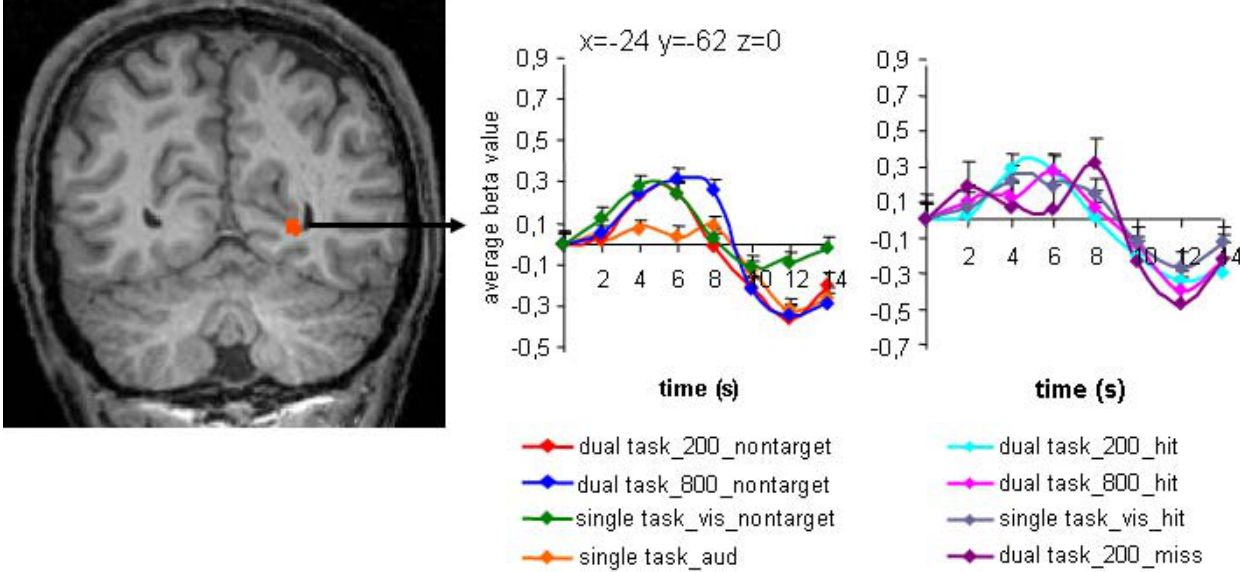
Figure 4. Results of the whole brain contrasts between dual task trials with long SOA and short SOA in modality specific cortices. Significant activity (p , .03, uncorrected; voxel threshold . 60) was found in modality-specific visual cortex (see also Table 2 ), but not in auditory regions. Time courses show activity for dual task trials with short and long SOA and nontarget letters (dual task_200_nontarget; dual task_800_nontarget), dual task trials with short and long SOA and successfully identified letter targets (dual task_200_hit; dual task_800_hit), single visual trials with nontargets and successfully identified letter targets (single task_vis_nontarget, single task_vis_hit), single auditory trials (single task_aud) and dual task trials with short SOA and letter target misses (dual task_200_miss), in contrast to the null trial activation baseline. Error bars indicate standard errors.